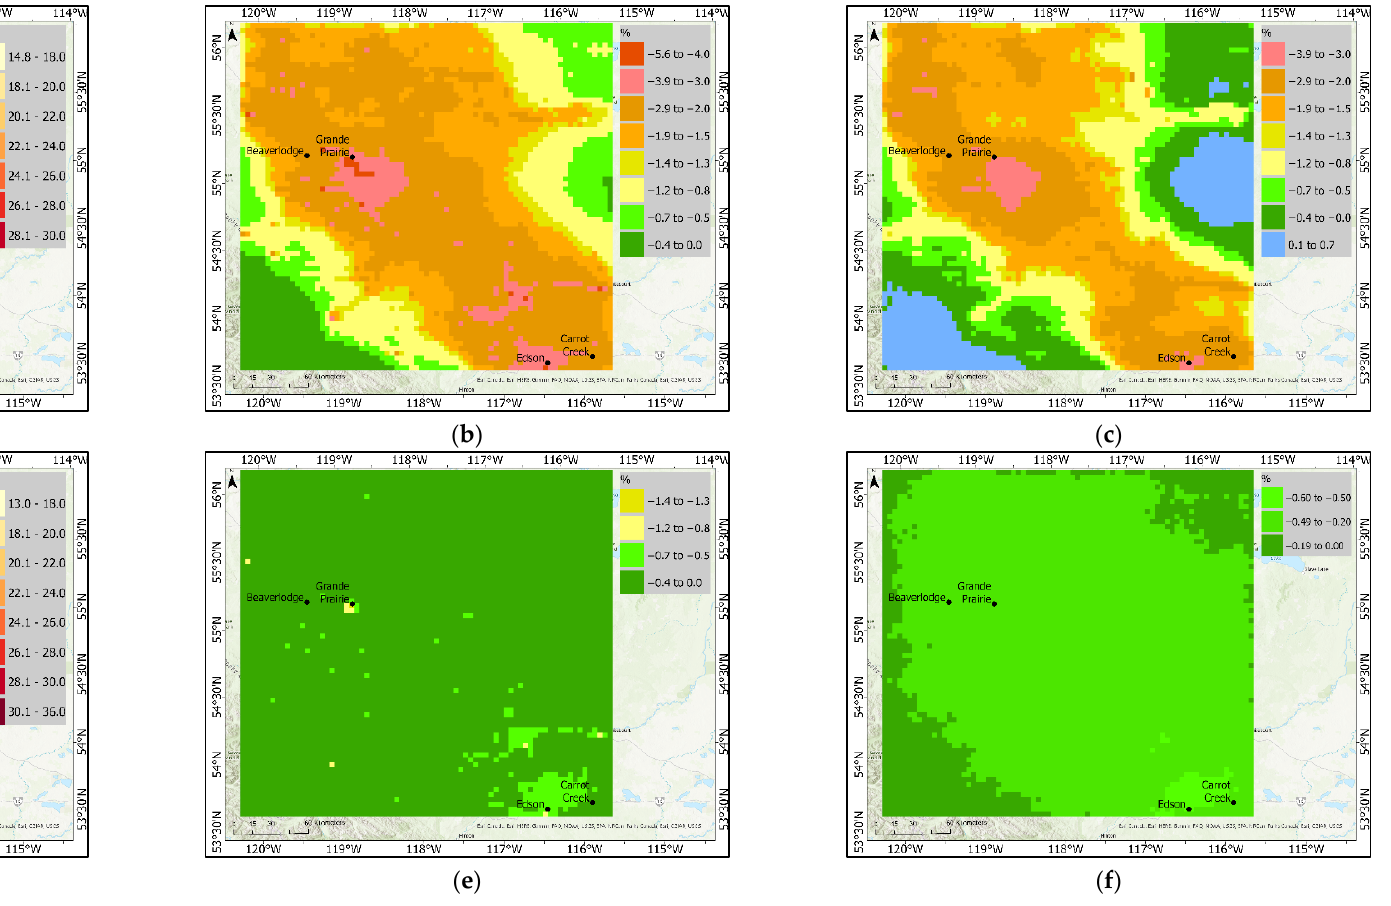
Figure 5. ( a ) Predicted average hourly O 3 concentrations for ( a ) CB6R3 (summer), ( b ) CB6R3 vs. SAPRC07 1 (summer), ( c ) CB6R3 vs. RACM2 2 (summer), ( d ) CB6R3 (winter), ( e ) CB6R3 vs. SAPRC07 1 (winter), ( f ) CB6R3 vs. RACM2 2 (winter). 1 [100*(SAPRC07 − CB6R3/CB6R3)] 2 [100*(RACM2 − CB6R3/CB6R3)].